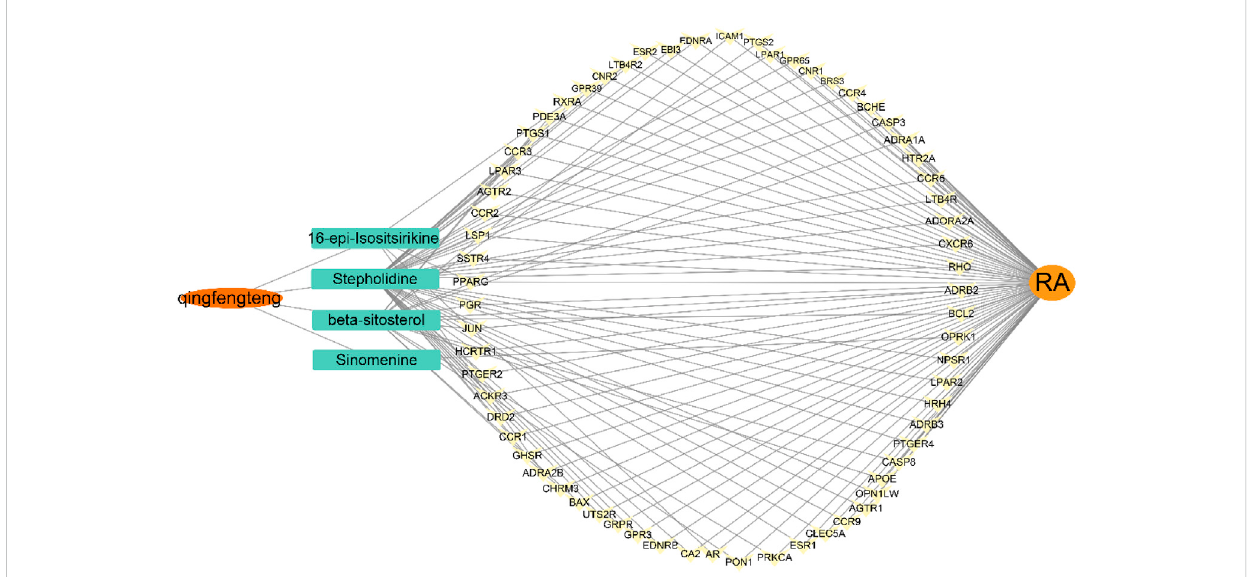
FIGURE 4 Network diagram of SA-Components-Potential targets of action-RA. The orange oval represents the drug (SA), the orange circle represents RA, the middle cyan rectangle represents the active ingredient, and the yellow represents the potential target of action between the two. The lines represent the relationship between SA, active ingredient, potential target of action, and